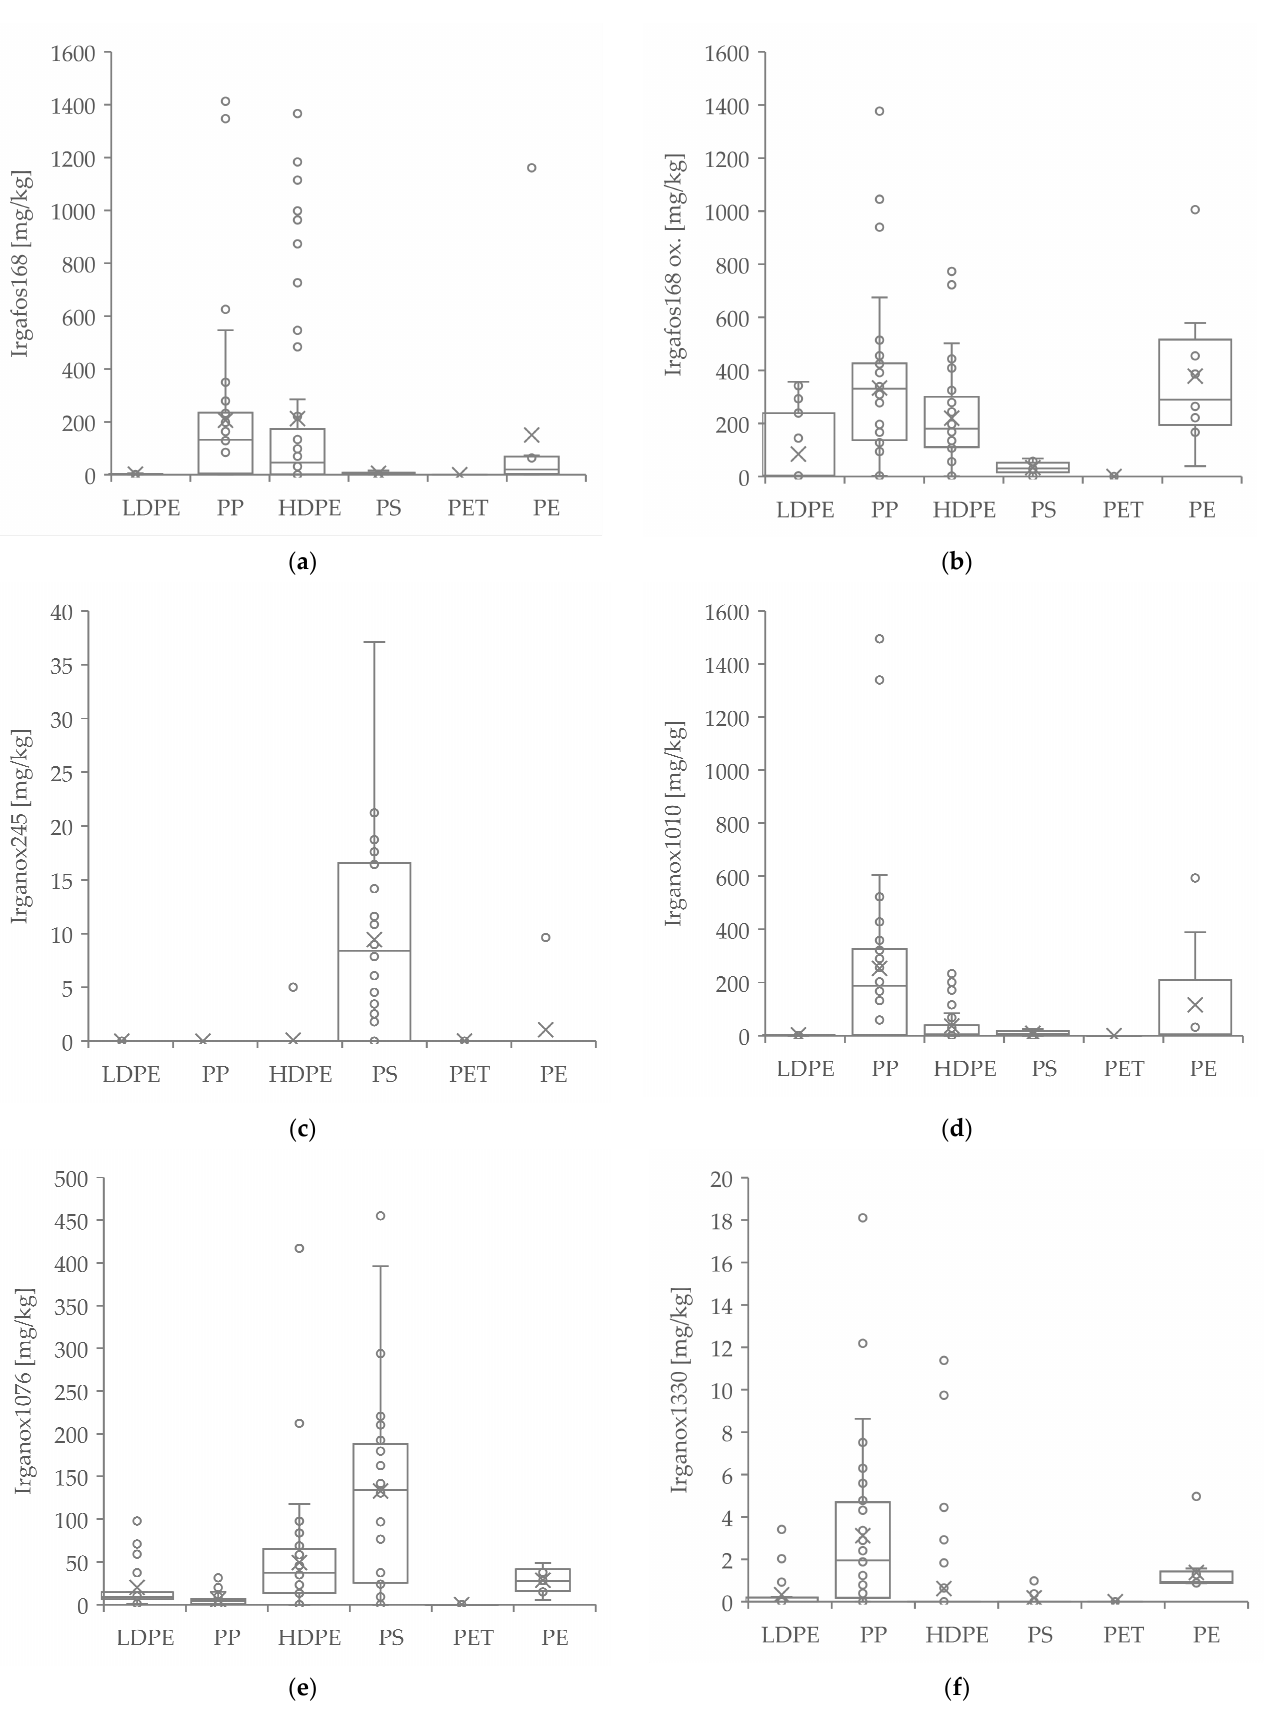
Figure 3. Quantification of additives Irgafos 168; oxidized Irgafos 168; Irganox 245; Irganox 1010; Irganox 1076 and Irganox 1330 ( a – f ) in different types of polymers. ( × = Mean, ◦ =